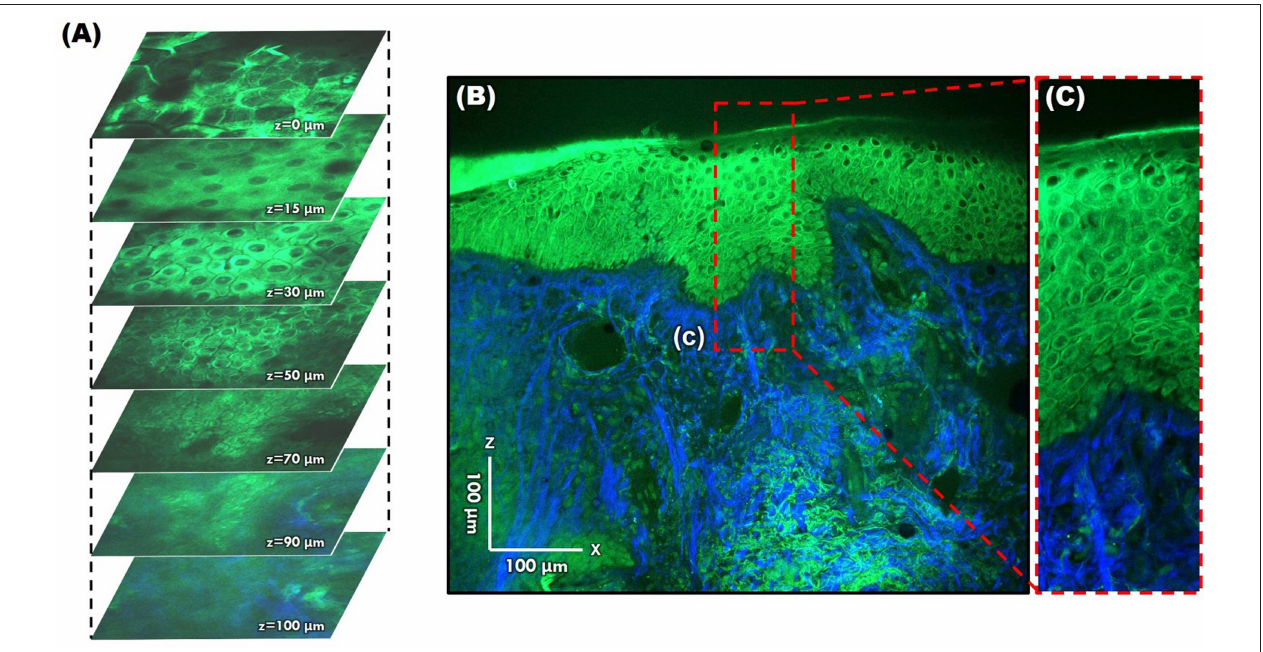
FIGURE 11 | Moxifloxacin-based multi-photon microscopy images of normal skin. (A) En face images at different depths. (B,C) Cross-sectional view of the epidermis and